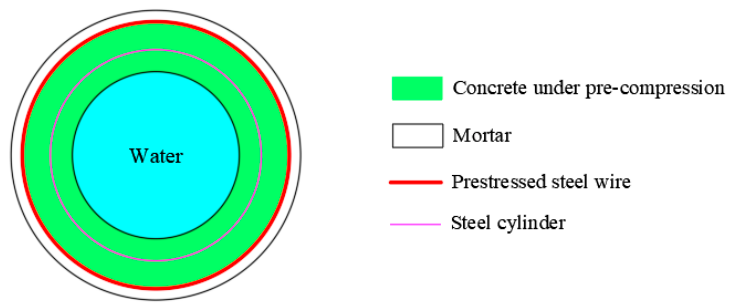
Figure 15. Prestressing stage.